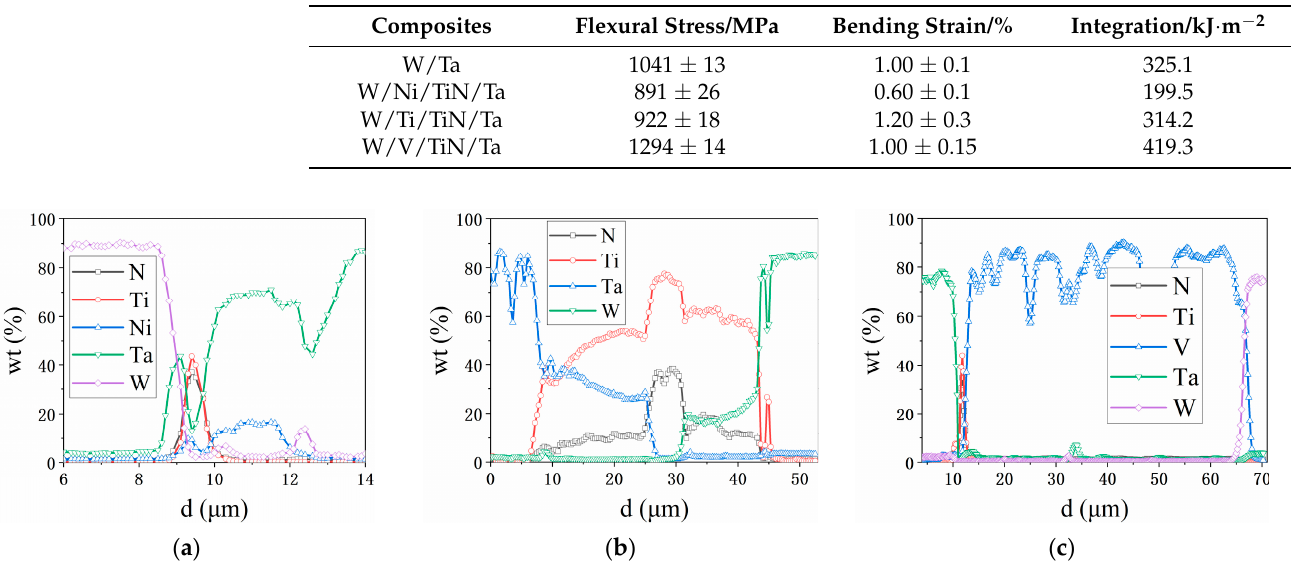
Figure 7. Element distribution near the interface of W/M/TiN/Ta-laminated composites with di ff